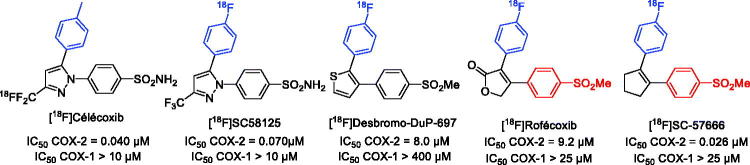
Structure of some [18F]coxib tracers.